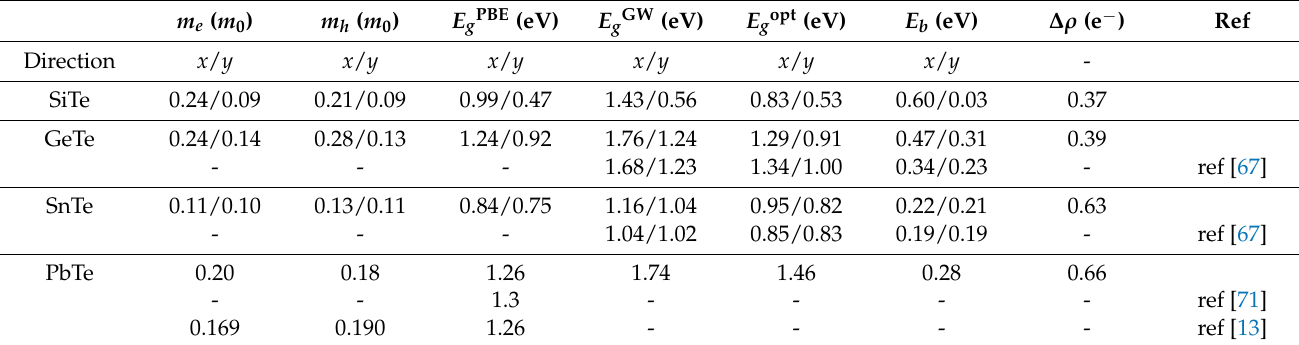
Table 2. Calculated carrier effective masses ( m ), PBE gaps ( E g PBE ), GW gaps ( E g GW ), BSE optical gaps ( E g opt ), exciton binding energies ( E b ) and Bader charge transfer ( ∆ ρ ) of monolayers SiTe, GeTe, SnTe, PbTe along different directions compared to previous